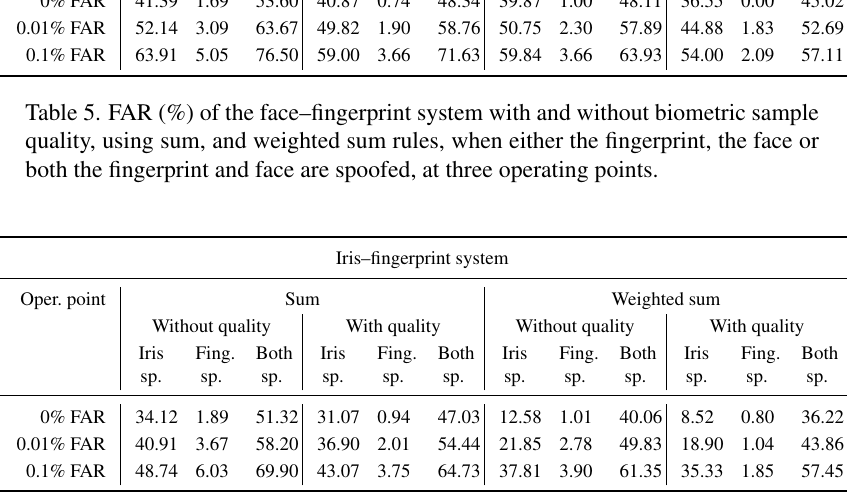
Table 6. FAR (%) of the iris–fingerprint system with and without biometric sample quality, using sum, and weighted sum rules, when either the iris, the fingerprint, or both the iris and fingerprint are spoofed, at three operating